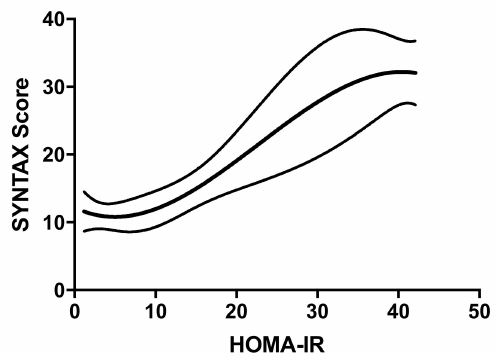
Figure 3. Plot of the non-parametric regression with natural cubic splines, showing the correlation between HOMA-IR and SS. This plot shows the correlation between HOMA-IR and SS. The upper and lower lines represent the 95% confidence intervals (CI). The equation used is the following: SS = 12.19 − 0.5812 * HOMA-IR + 0.06551 * (HOMA-IR)2 − 0.0009619 *